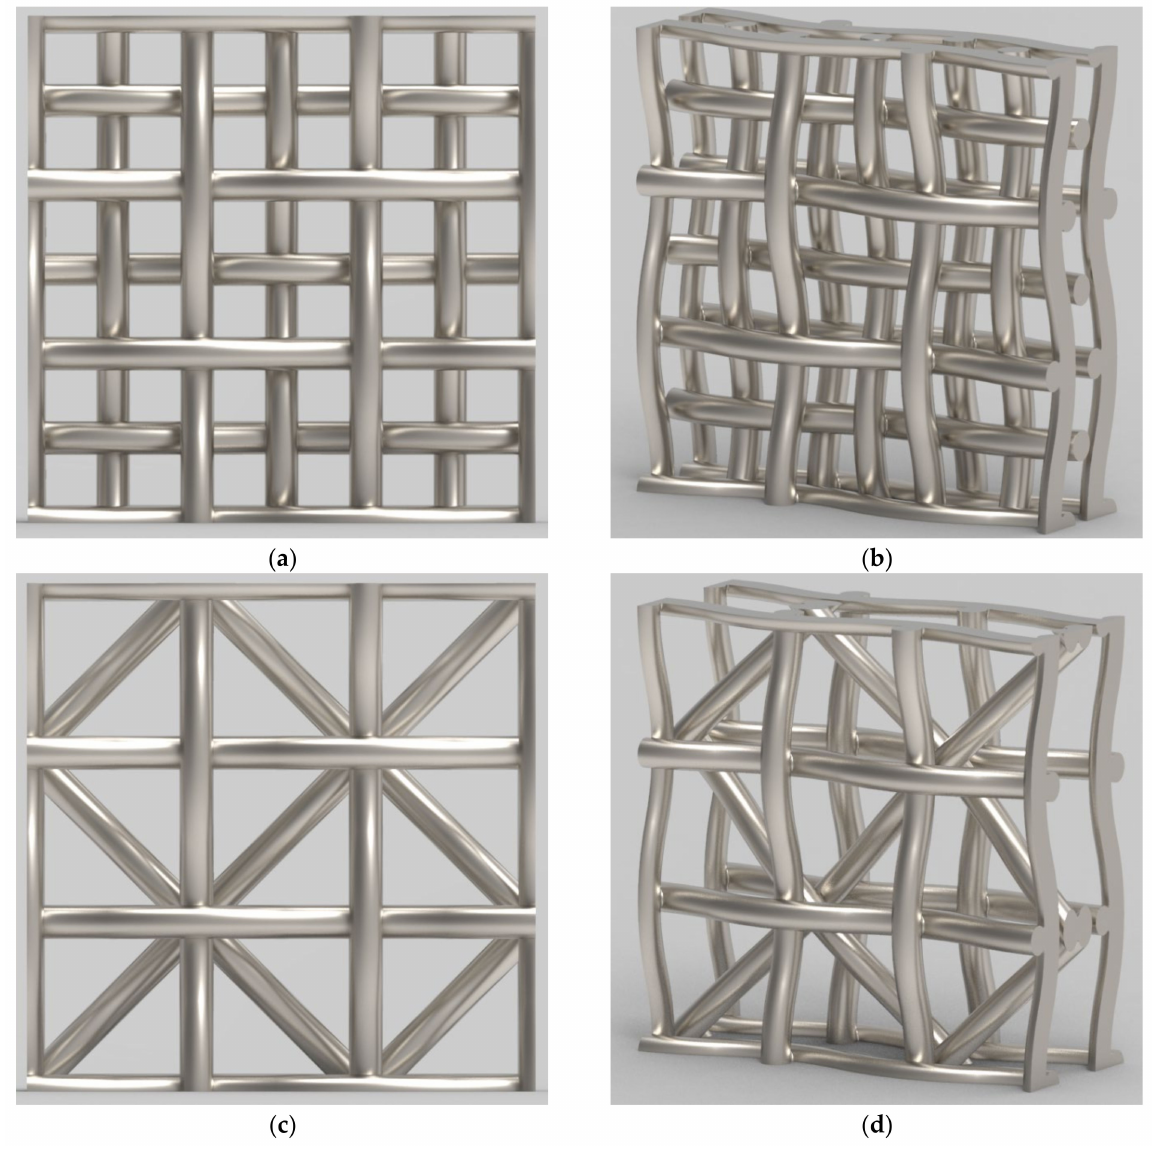
Figure 2. The visualisation of catalyst gauze: ( a , b ): typical catalyst gauze (Geometry A); ( c , d ): novel variant of catalyst gauze (Geometry